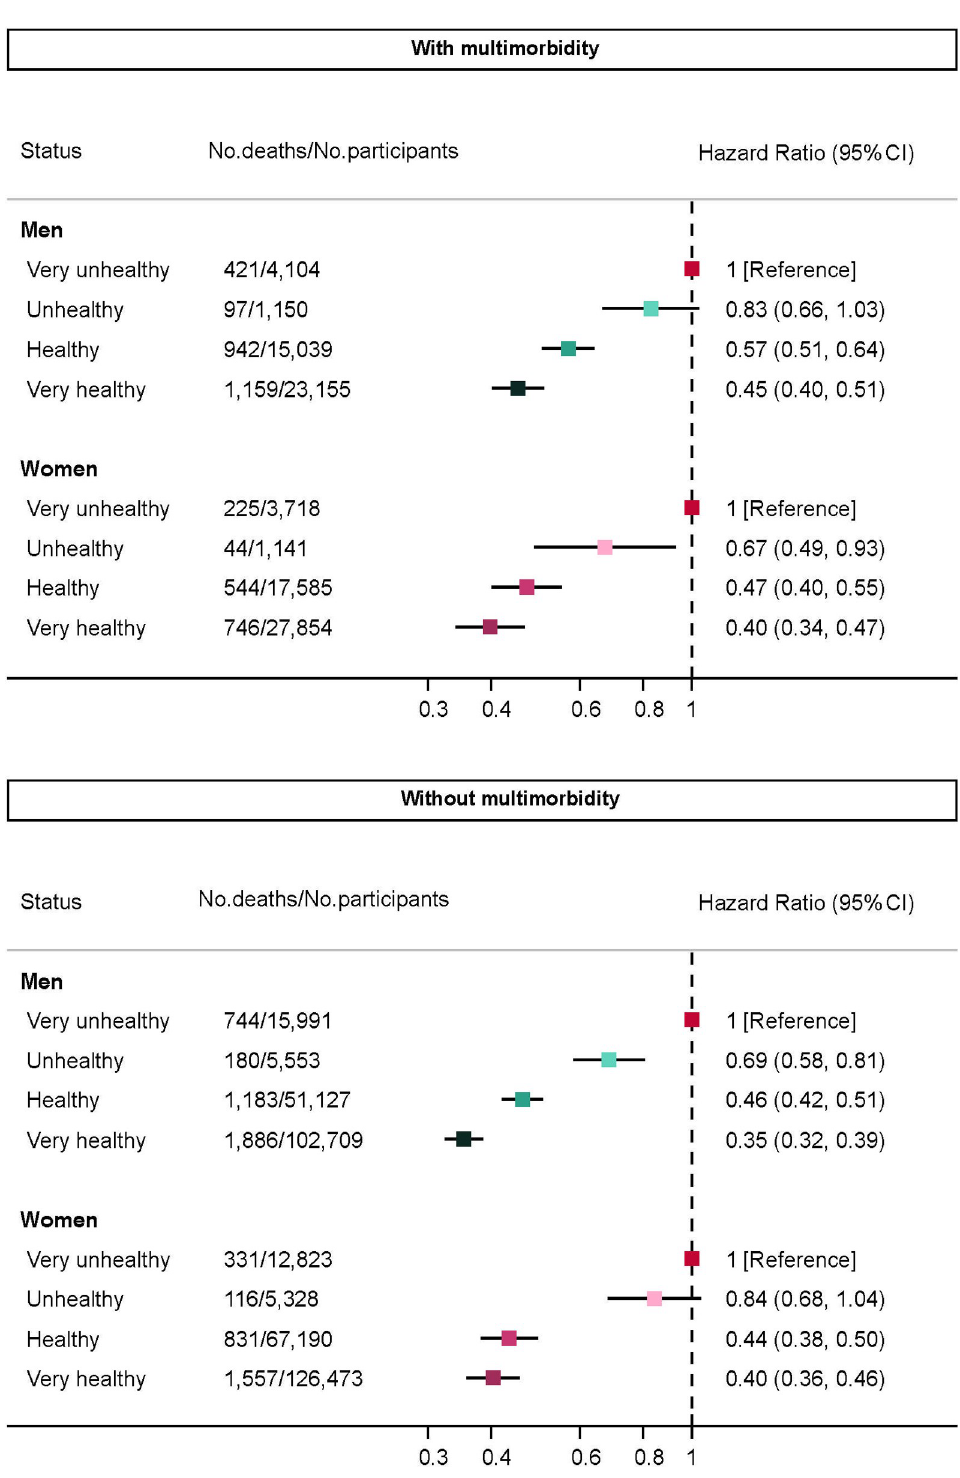
Fig 1. HRs of death by lifestyle score. Models adjusted for ethnicity (white, non-white), working status (working, retired, other), deprivation (continuous), body mass index (continuous), sedentary time (continuous). CI, confidence interval; HR, hazard ratio; No.,